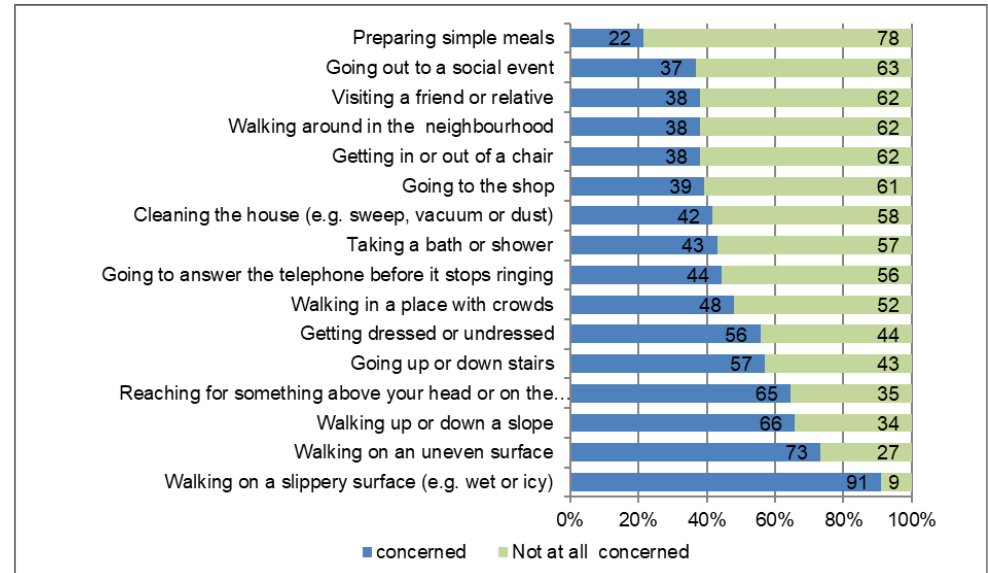
Figure 1. Item level of the Falls Efficacy Scale International (FES-I). Table 3. Spearman correlation with fear of falling